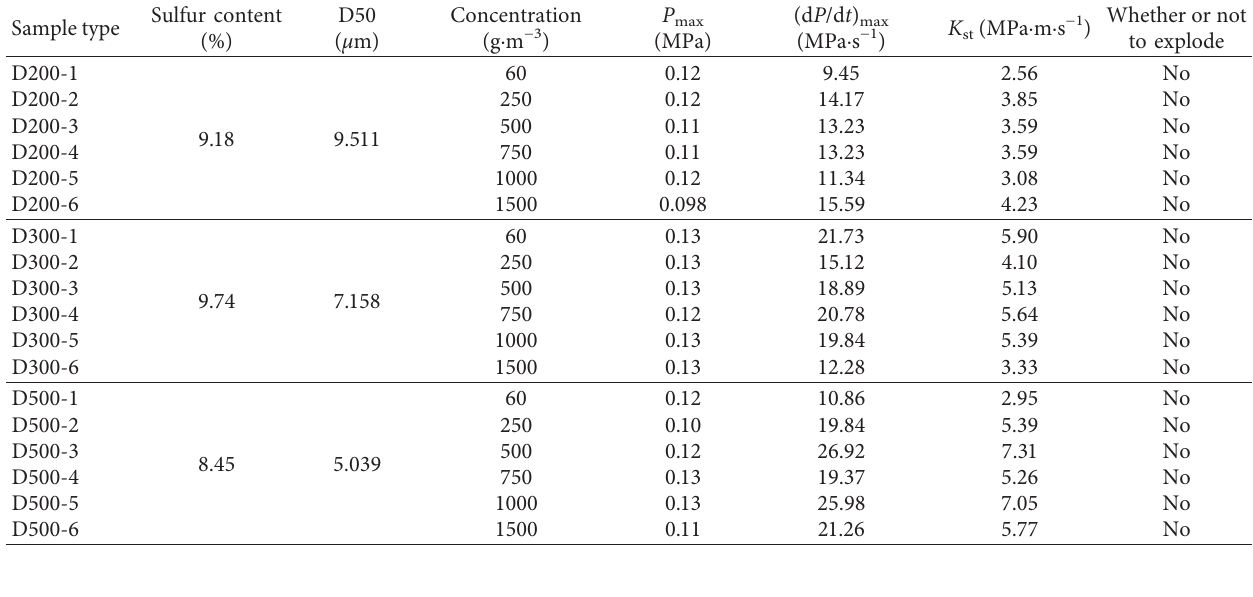
Table 7: Summary of explosion pressure data for D group.